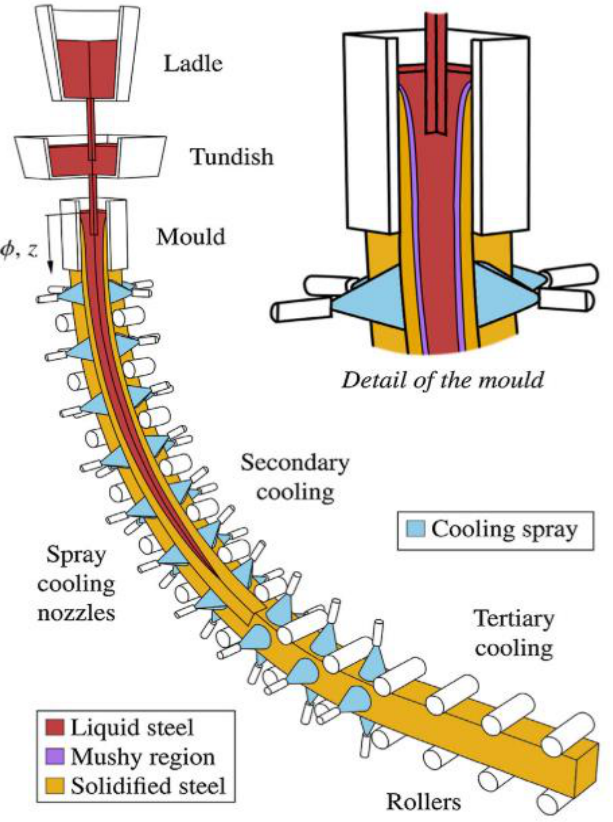
Figure 1. Radial continuous casting machine (CCM) depicting primary, secondary and tertiary cooling zones [3] (with the permission of Elsevier).